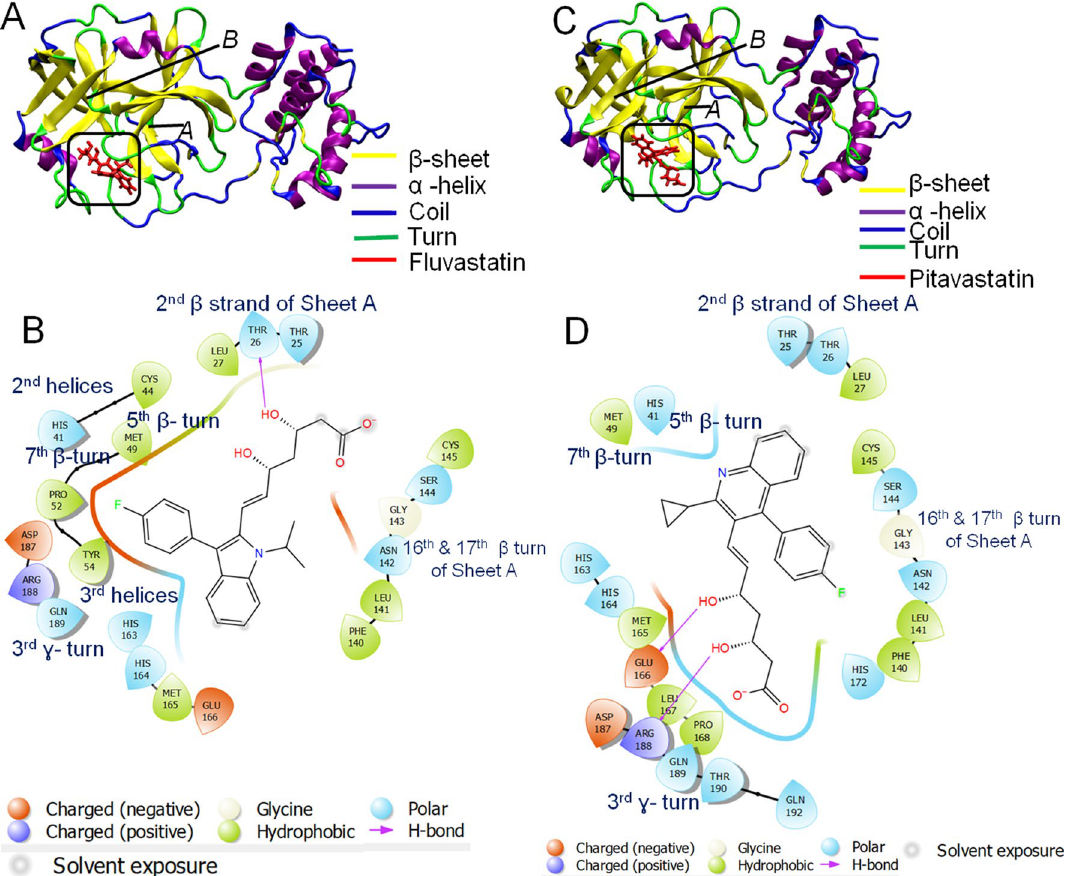
Figure 5. Molecular docking study of Fluvastatin and pitavastatin to 3-CL-Pro. (A,C) 3D diagram of fluvastatin-3-CL-Pro complex and pitavastatin-3-CL-Pro complex, respectively. (B,D) 2D diagram for representation of interactions of ligand molecule with the amino acid residues at the binding site; (B) fluvastatin-RdRp complex and (D) pitavastatin-RdRp complex. All 3D images were generated using the VMD (visual molecular dynamics) software (version 1.9.3) and 2D images were generated by the graphical user interface Maestro, Schrödinger (https:// www. schro dinger. com/ produ cts/ maest emodel score, glide energy, and MMGBSA scores for ML188 (positive control) were −6.38–47.05–67.01, and −39.93 kcal/mol, respectively (Table 4). Thus the results indicated the strong affinity of fluvastatin and pitavas- tatin towards the enzyme. Characterization of the binding cavity of Fluvastatin revealed that it is partly hydrophilic (Fig. S5C, Blue color). The binding cavity is comprised of the residues like THR 25, THR 26, TYR 54, ASP 187, and GLN 189, which impart a polar (hydrophilic) character to the binding pocket(Fig. S5C). As per ionizibility, the binding site mainly was neutral due to the presence of the residues like THR 26, HIS 41, TYR 54, and CYS 145 (fade white color, Fig. S5D), while only GLU 166 was acidic (slightly brown in color, Fig. S5D). The presence of H-donor amino acid residues (THR 26, HIS 41, TYR 54, and CYS 145) and H-acceptor amino acid residue (GLU 166) results in H-bond formation with fluvastatin. Additionally, the fluorine atom of fluorophenyl (C 6 H 5 F-) group of fluvastatin was involved in chemical interaction with ASP 187 residue, present in 2nd ɣ -turn of the protein, while the O-atoms of polyhydroxy groups (-OH) interacts with the HIS 41 residue, present in 2nd helices. Moreover, the alkyl group of fluvastatin had hydrophobic interactions with CYS 145 and HIS 163, present on the 12th β strand of β sheet and 17th β turn, respectively (Fig. 5B). All these interactions contributed to a stable fluvastatin-3CL-Pro complex. Due to the similar LogP values (Table S1), the binding pocket for pitavastatin is similar to that of fluvasta- tin. The binding site of pitavastatin was slightly basic due to the occurrence of the basic amino acid residues like HIS 41, HIS 163, HIS 164, HIS 141, and ARG 188(Fig. S6D). HIS 41 acts as H-donor while GLU 166 and ARG 188 act asH-acceptor and participate in the formation of conventional H-bond with hydroxyl groups of pitavastatin(Fig. S6E). The electron cloud of the fluorophenyl group of pitavastatin contributed to π–π stacked interaction with LEU 141, present in the 16th β turn of the protein (Fig. 5D). All these interactions contribute to the formation of a stable pitavastatin—3CL-Pro complex. The compound ML188 was taken as the positive control 83 (Table 4).